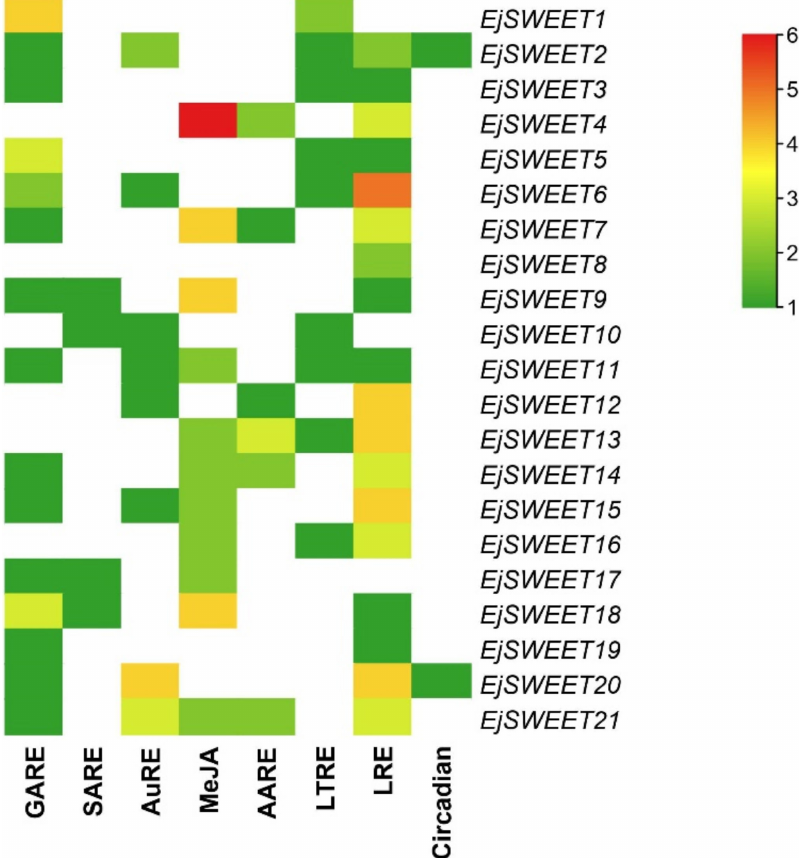
Figure 4. The promoter region analysis ( cis -regulatory elements) of EjSWEET genes. Maximum and minimum number of cis -elements are denoted by red and green boxes,